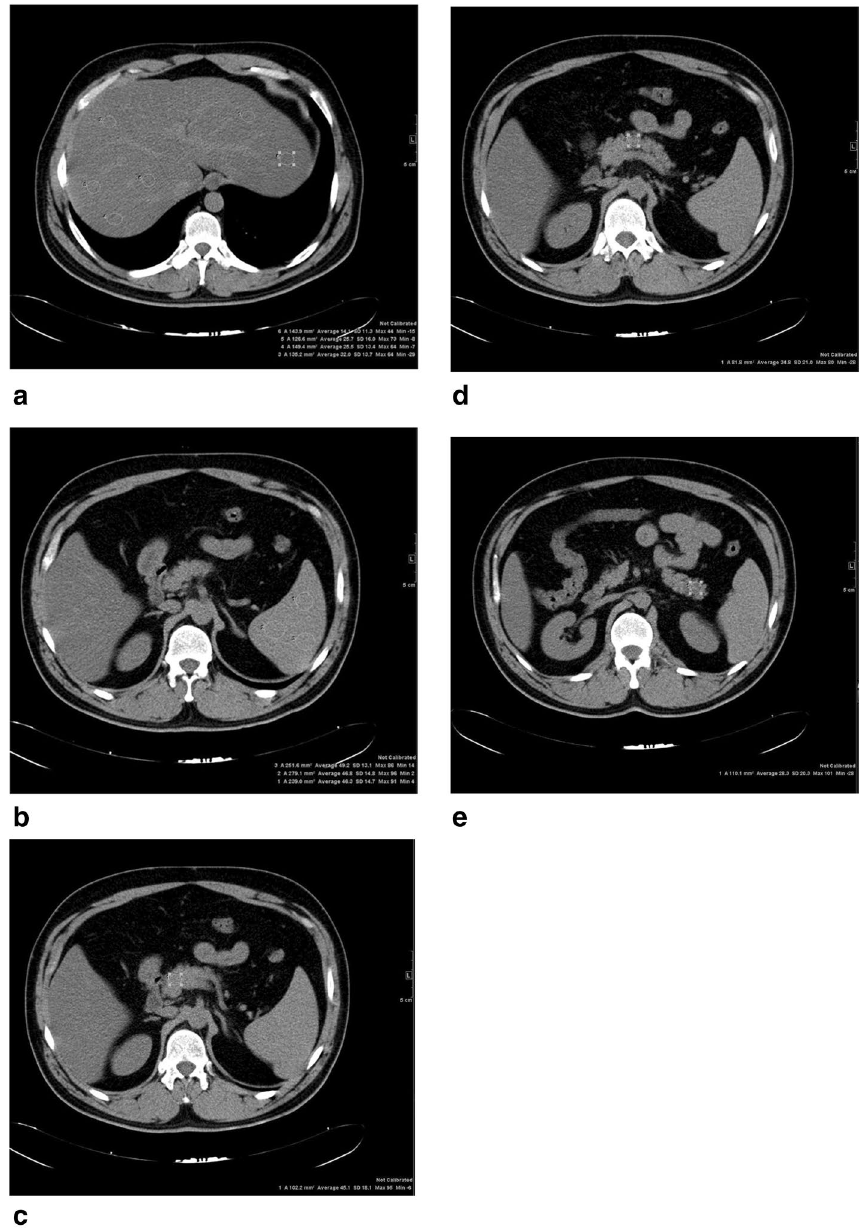
Figure 1. Images of a 35-year-old male who is a candidate for liver donor with hepatostaetosis. ( a – e ) Unhanced transverse CT images are shown. HU was measured with ROI from liver, pancreatic head, body, tail and spleen. Mean pancreatic and splenic CT attenuation was 37 and 47 HU, respectively. Difference between pancreatic and splenic attenuation (P-S) and pancreas-to-spleen attenuation ratio (P/S) were − 10 HU and 0.79. Pancreatic steatosis grade 2 was found according to the parameters used. (P mean , P-S, P/S). The liver attenuation index was found < − 10 and was accepted as steatosis >